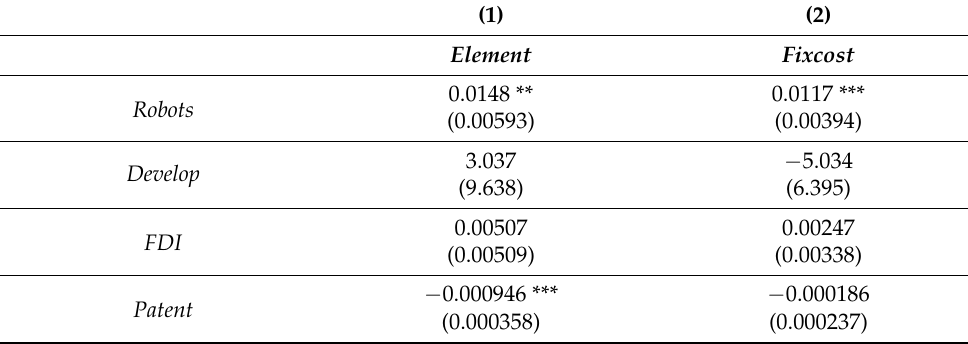
Table 7. Test results of the action